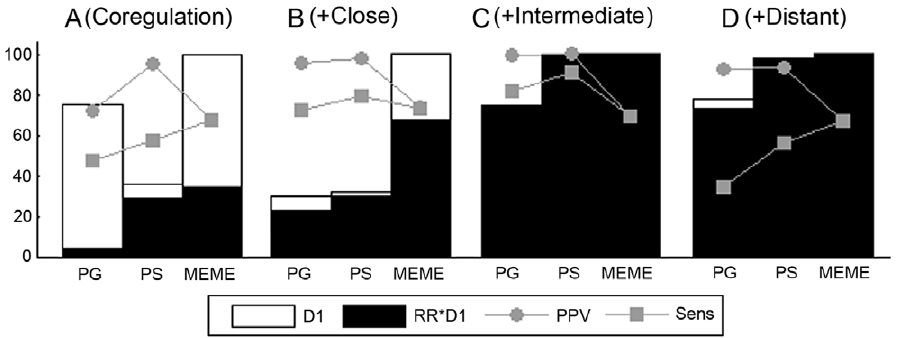
Figure 3. Effect of adding orthologs with distinct phylogenetic distances on motif detection in the combined space. Results are displayed on the retrieval of a low IC motif in a synthetic dataset. Panel (A) shows the results for the coregulation space that consists of ten coregulated reference genes. The remaining panels represent the results for the combined space that consists of the ten coregulated reference genes together with their orthologs, also referred to as ten orthologous sets. Each orthologous set consists of five prealigned sequences related through an equal star topology: the reference sequence with proximity 0.80 and four equally distant sequences with proximities of respectively 0.90 (B), 0.50 (C) and 0.20 (D). For the measures D1, D1*RR, PPV and Sens see Figure 2.